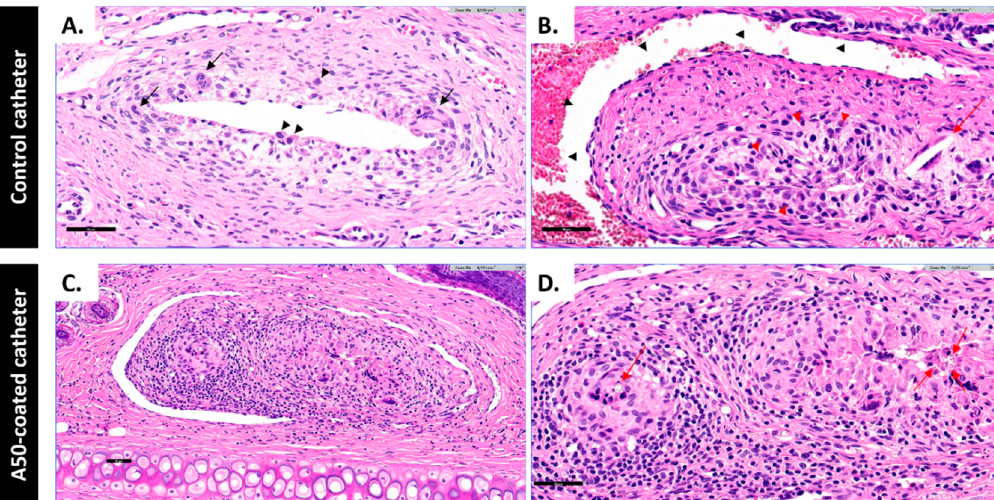
Figure 8. Representative images stained with hematoxylin–eosin of rabbit marginal ear veins from each group from the coagulation model: ( A ) granulomatous inflammation with histiocytes (black arrows) which were not forming granuloma-like aggregates; ( B ) inflammatory pseudothrombotic injury lined by a layer of endothelial cells (black arrows) with giant cells (red arrows); ( C ) well-formed granulomas with plasma cells, lymphocytes and scarce mast cells; and ( D ) granuloma with multinucleated giant cells contained an amorphous crystalline material inside (red arrows). The bar represents 50 µm.